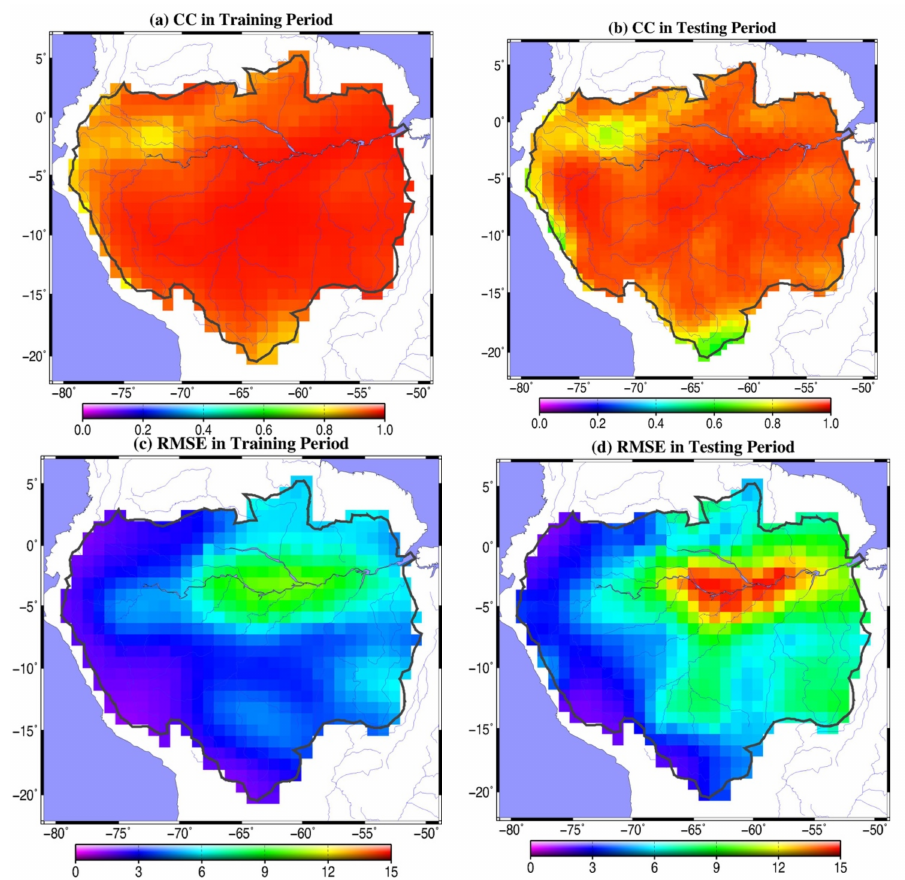
Figure 2. Correlation coefficients (CCs) of the climate-driven total water storage change (TWSC) fields over the Amazon basin in the ( a ) training and ( b ) testing periods compared with the Gravity Recovery and Climate Experiment (GRACE) TWSC. Root-mean-square error (RMSE) of the climate- driven TWSC fields over the Amazon basin in the ( c ) training and ( d ) testing periods as evaluated by the GRACE